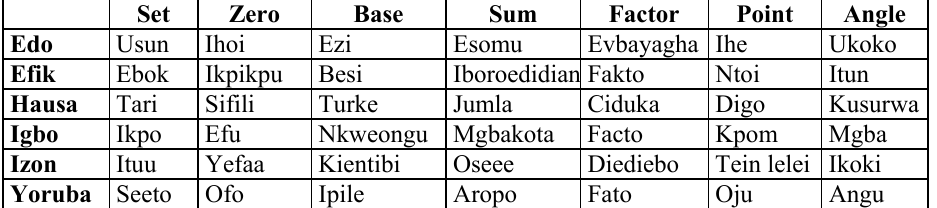
Table 1: Sample of mathematical terminology in six Nigerian languages Set Zero Base Sum Factor